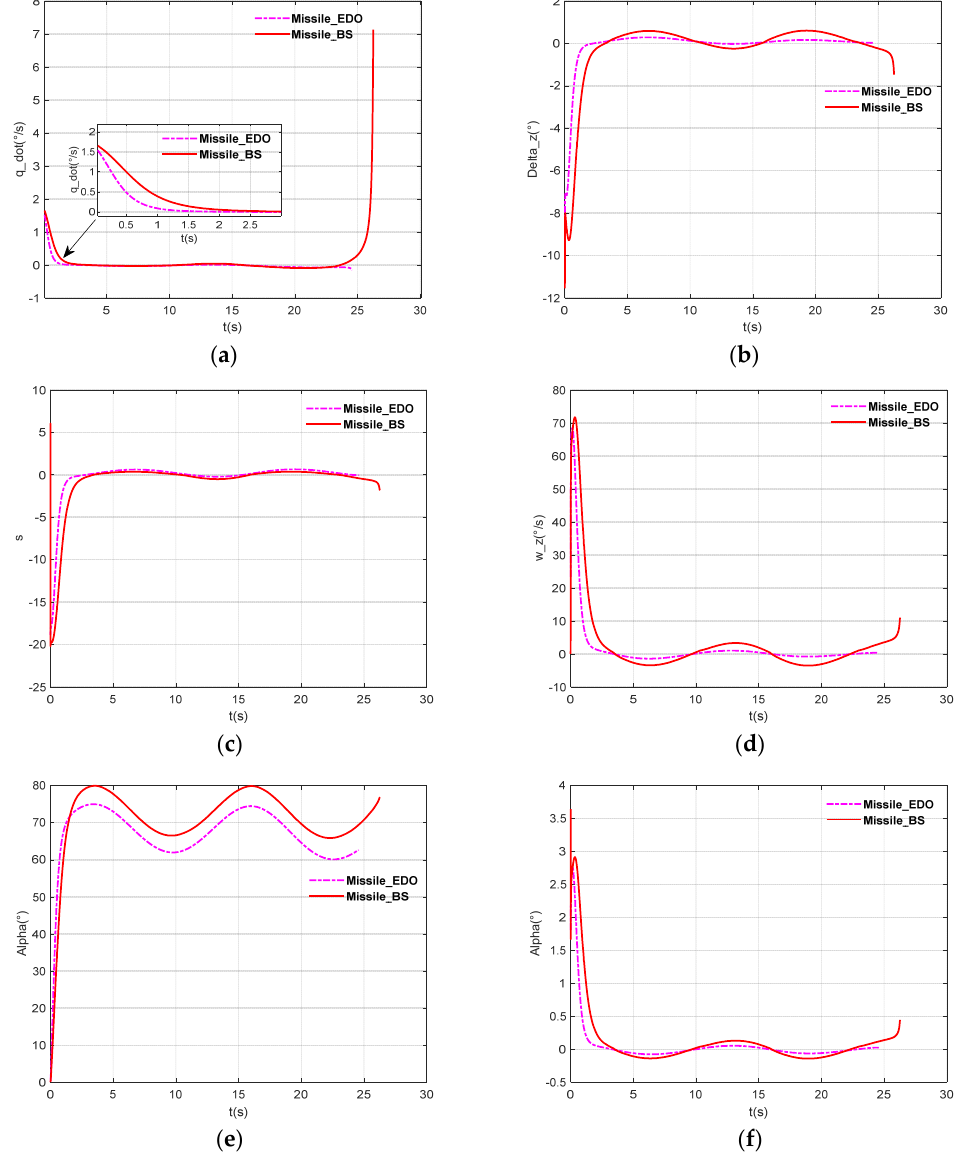
Figure 5. ( a ) The curve of LOS angular rate; ( b ) The curve of rudder deflection; ( c ) The curve of the sliding mode surface proposed in this paper; ( d ) The curve of the pitch angular rate; ( e ) The curve of the pitch angle; ( f ) The curve of the attack angle.